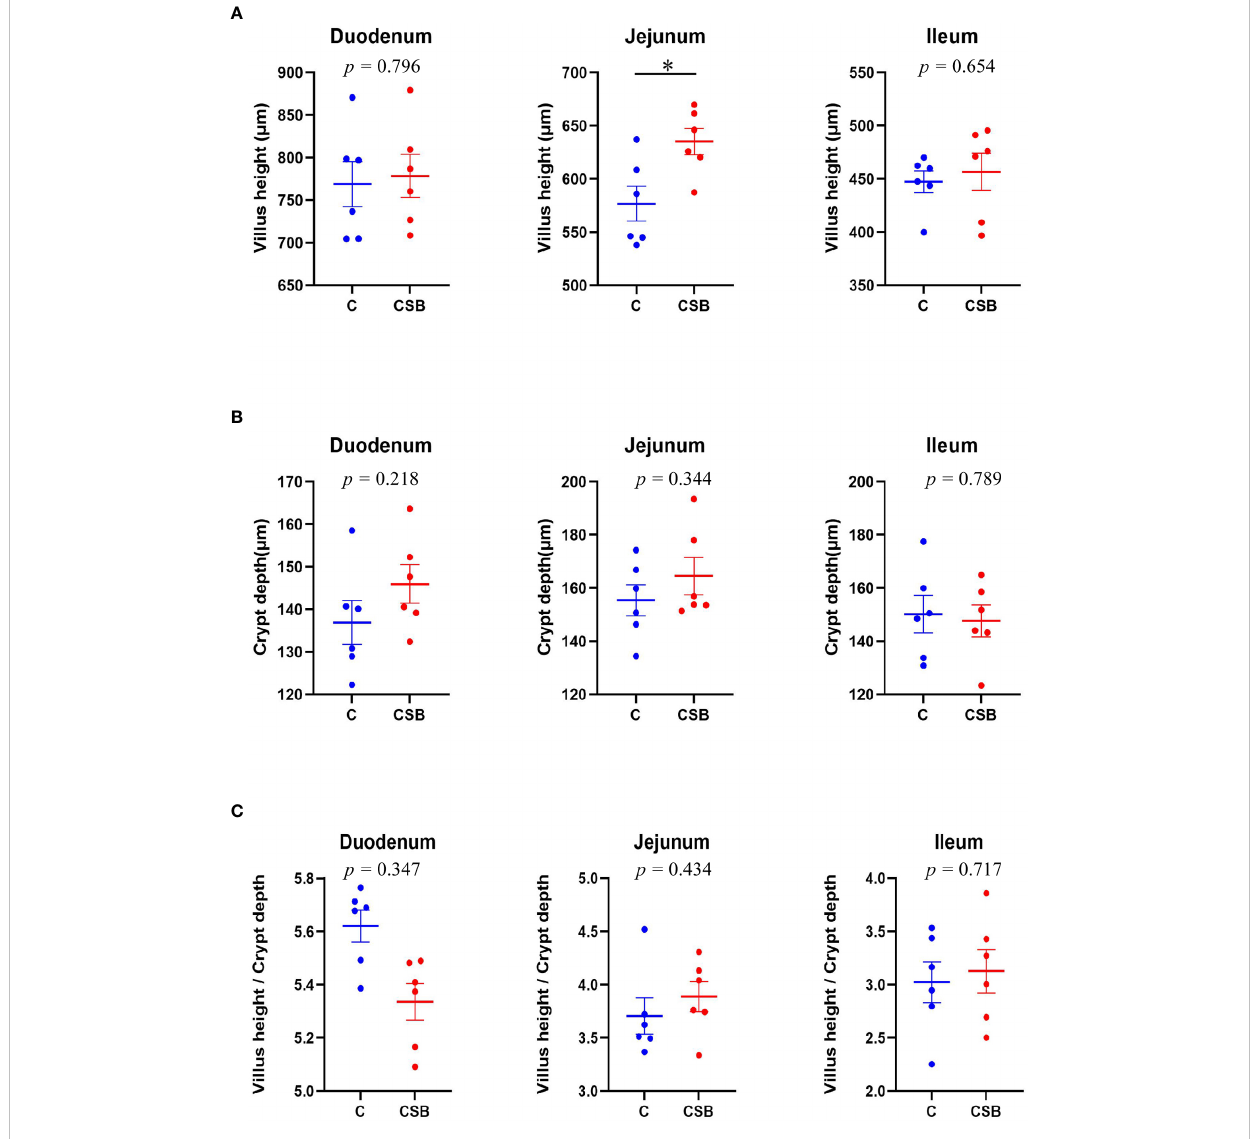
FIGURE 5 Effects of dietary supplementation of coated sodium butyrate (CSB) on the morphometric characteristics of the duodenum, jejunum, and ileum of laying ducks. (A) Villus height (VH) of small intestines. (B) Crypt depth (CD) of small intestines. (C) VH/CD ratio of the small intestines. Values are presented as means ± SEM (n = 12). * p< 0.05. group C, Control group, which was fed a basal diet; CSB group, CSB-treated group, which was fed the basal diet supplemented with 250 g/t of